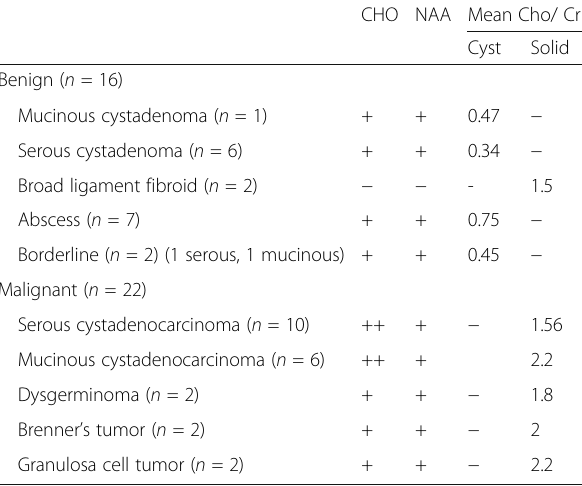
Table 9 Summary of the detected metabolite peaks within